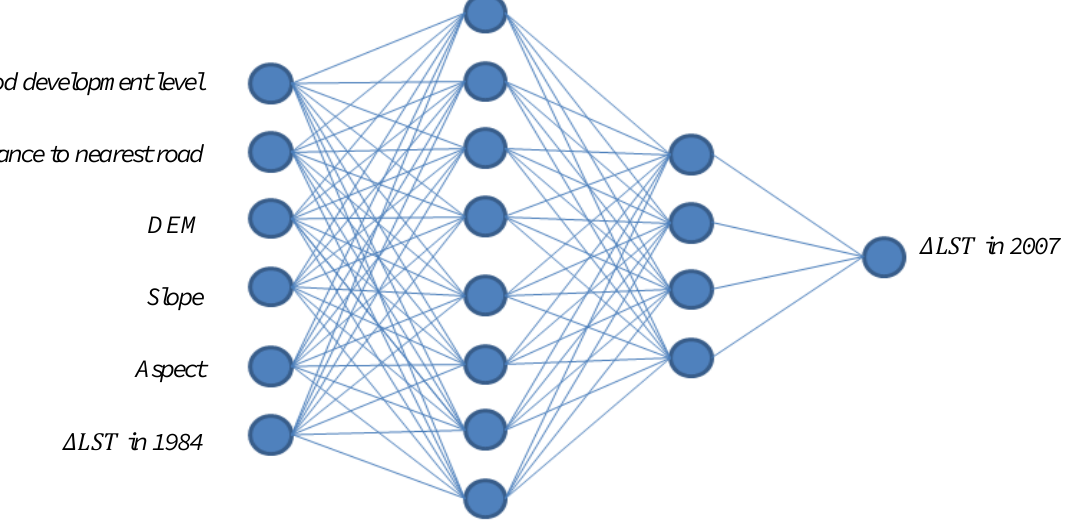
Figure 1. Configuration of proposed ANN for simulation of